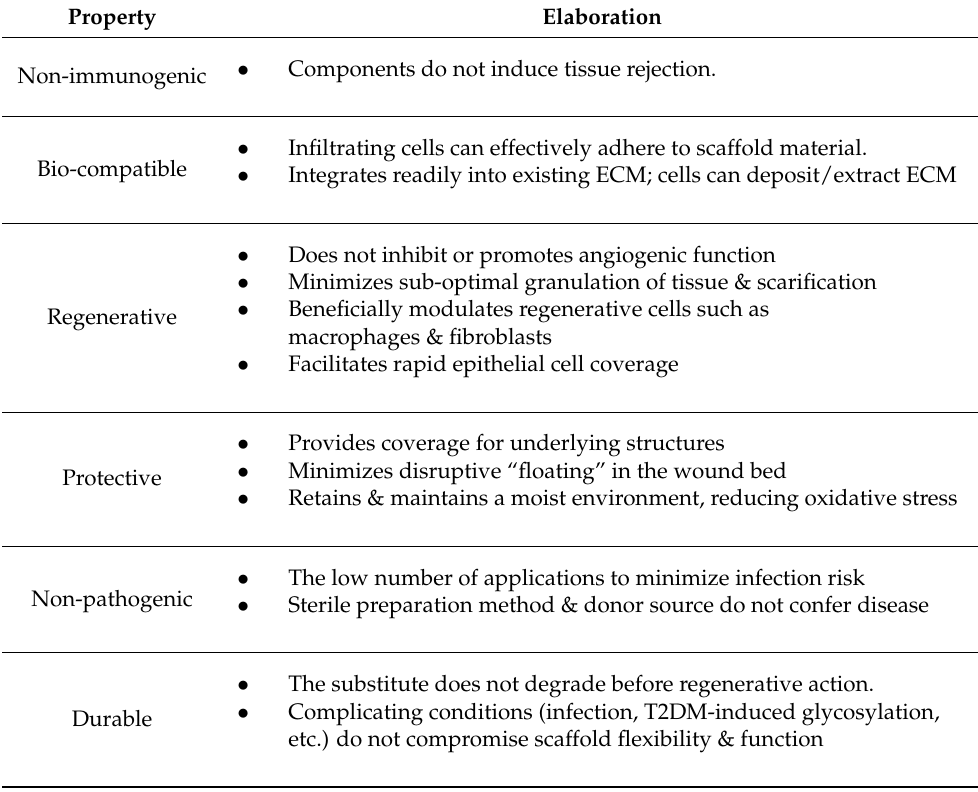
Table 3. Ideal properties of skin